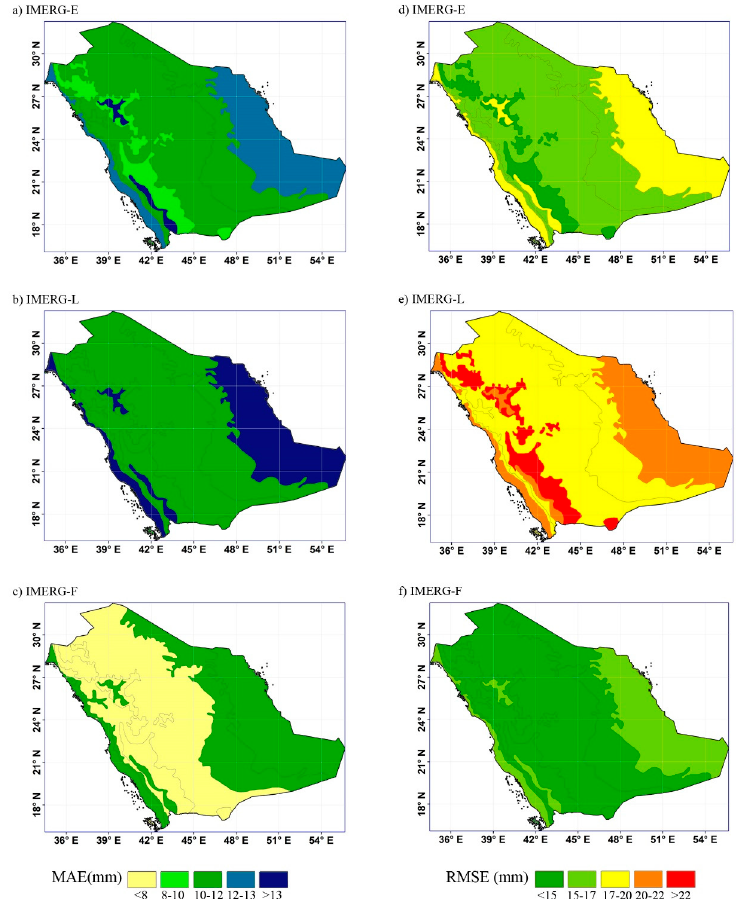
Figure 7. Evaluation of IMERG products for the different topographical regions using MAE measurements for ( a ) IMERG–E, ( b ) IMERG-L, and ( c ) IMERG-F and RMSE indicator for ( d ) IMERG-E, ( e ) IMERG-L, and ( f ) IMERG-F.